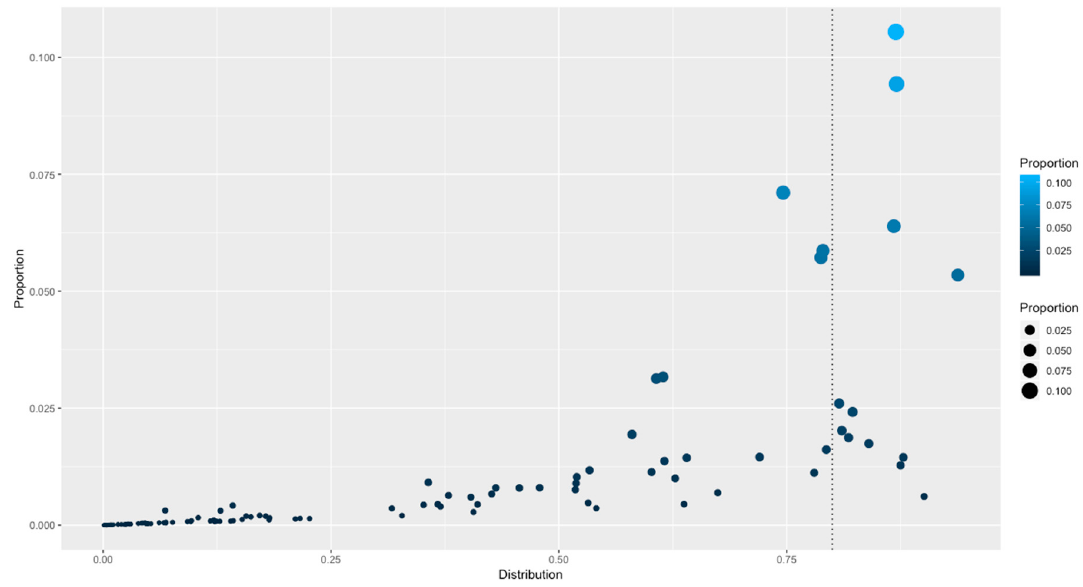
Figure 3. Distribution of TF families among all the genomes. The X-axis indicates the distribution (as a percentage) of genomes with members of a given family. 0 represents absence of a family and 1 means that a family is distributed along all the organisms. The Y-axis indicates the proportion of families versus the total of TFs identified. The vertical dotted line indicates those families identified in more than 80% of organisms.